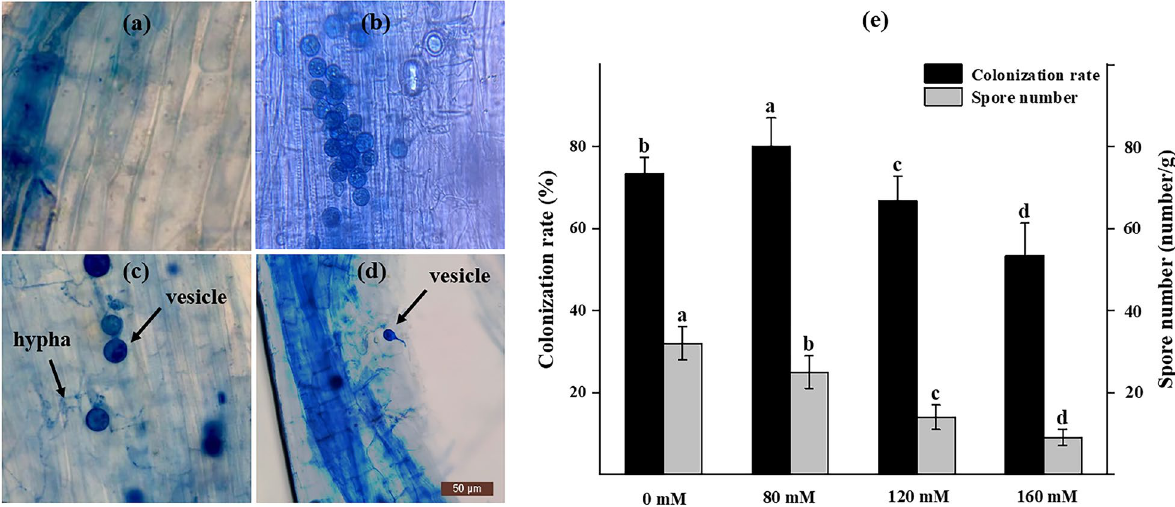
Fig. 1 The rice root colonization of AMF under the microscope (400x) and their effective colonization in terms of colonization rate and spore number. Note: a nm treatment group; b AMF spores in rhizosphere soil; c Fm mycorrhizal colonization rate and the number of spores in the rhizosphere soil. The results are presented as the mean replicates. Different letters indicate differences between different treatments ( P < 0.05)